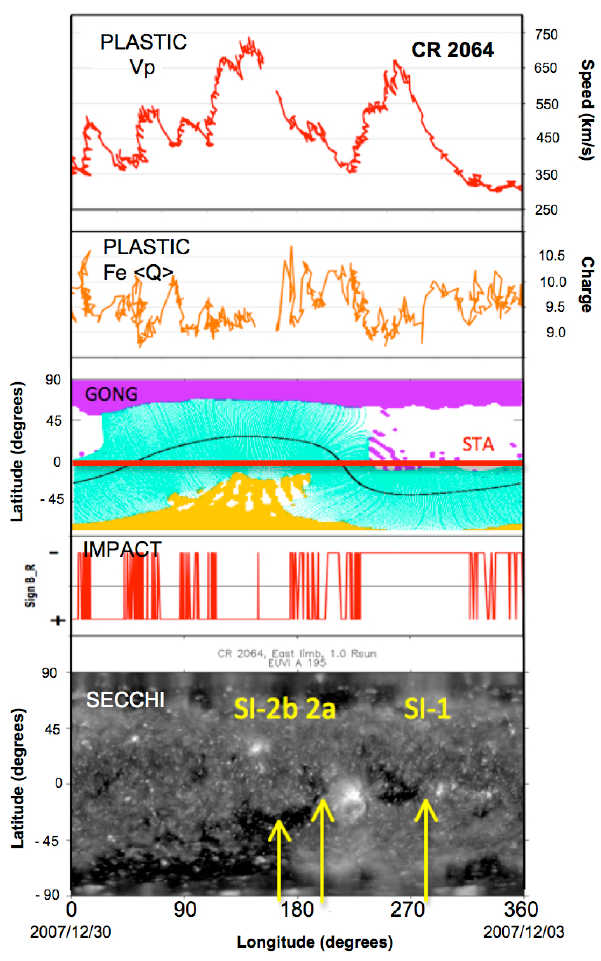
Fig. 7. Mapping solar wind to solar origins. From top to bottom: STEREO A (STA) PLASTIC proton speeds back-mapped to their originating Carrington Rotation (CR) number, or equivalently, Car- rington Longitude; PLASTIC Fe < Q > ; GONG coronal hole syn- optic map for CR 2064, showing the coronal holes, their magnetic polarity, and the current sheet as a function of both latitude and longitude, and the STEREO A projected trajectory superimposed; Signage of the radial component of the STEREO A IMPACT/MAG interplanetary magnetic field, indicative of the in-situ magnetic po- larity; Solar synoptic map from SECCHI EUVI. Vertical arrows in- dicate the location of stream interfaces SI-1, SI-2a, and SI-2b iden- tified by Simunac (2009). Note that time is reversed in this